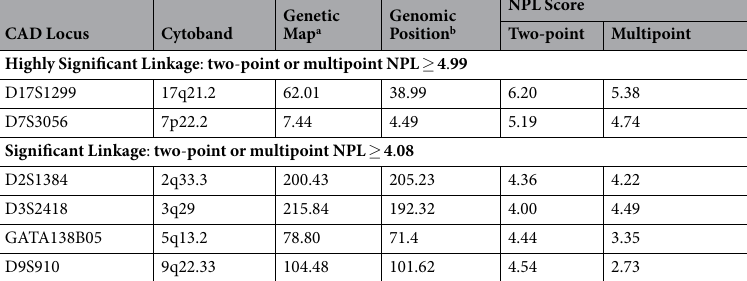
Table 2. Genomic Regions Significantly Linked to CAD as Identified by GWLS in the Combined GeneQuest II Families: Two Highly Significant Linkages and Four Significant Linkages. a The genetic map position was based on Marshfield Medical Genetic marker set 11. b Physical genomic position was retrieved from the UCSC database with human build